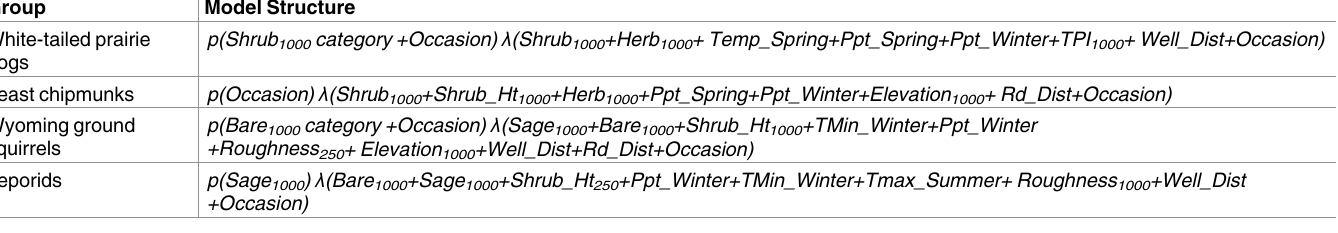
The top-performing detection model ( p ) was used with all abundancemodels during multivariate model selection, while the covariates in the global abundancemodel, λ , were used to create six candidate abundancemodels (see text for details). The scale at which each variable was selected, either 250 m or 1000 m, is given in subscript. Covariates are defined in Table